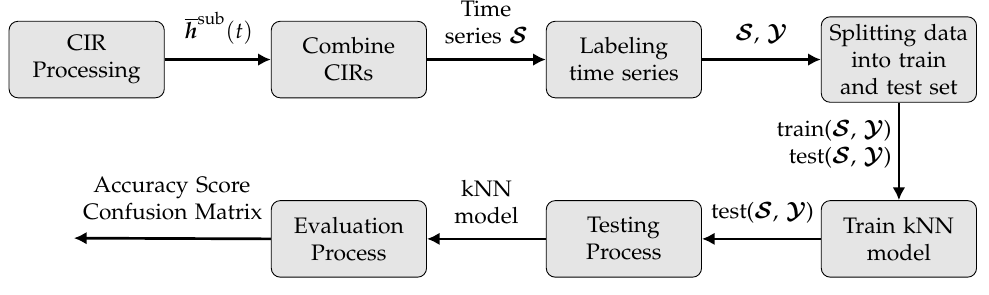
Figure 9. CIR kNN classification